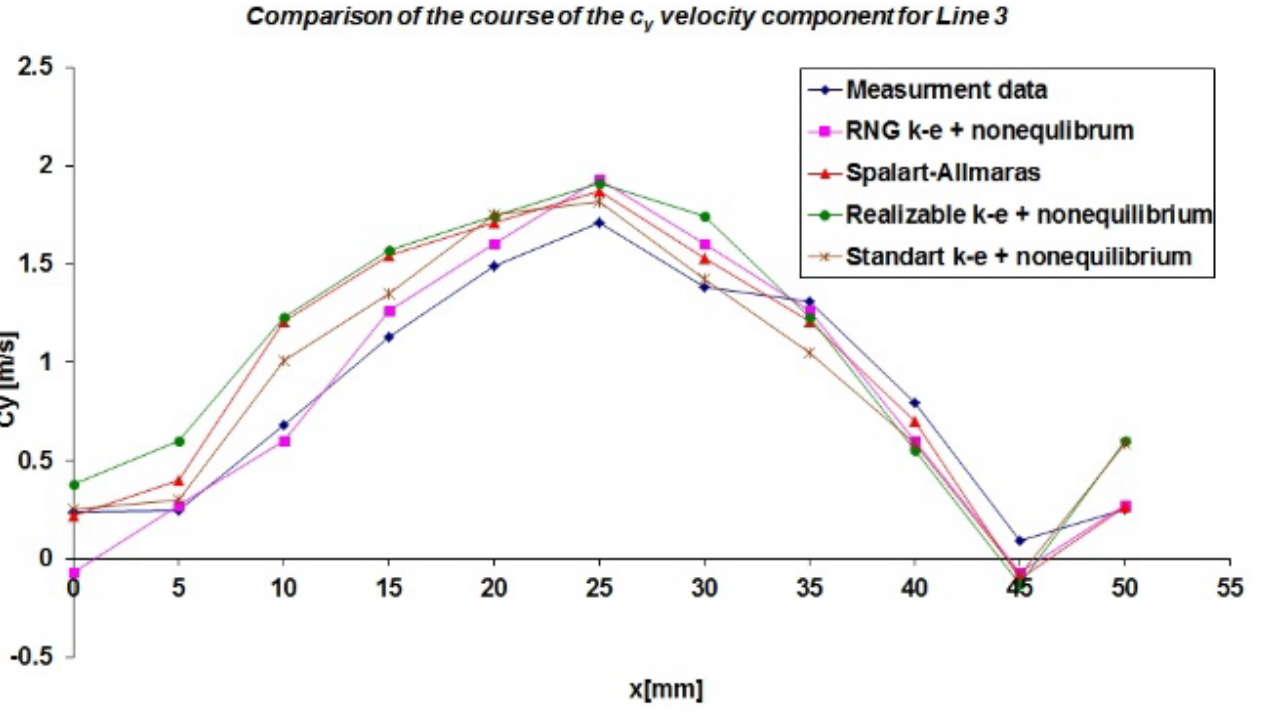
Figure 15. Comparison of the course of the cx, cy velocity components for Line 3.